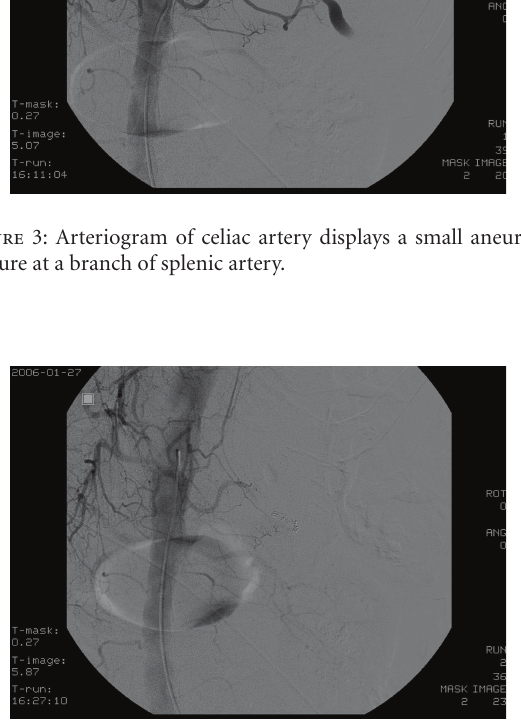
Figure 4: Arteriogram after embolization to a splenic aneurysm demonstrates no